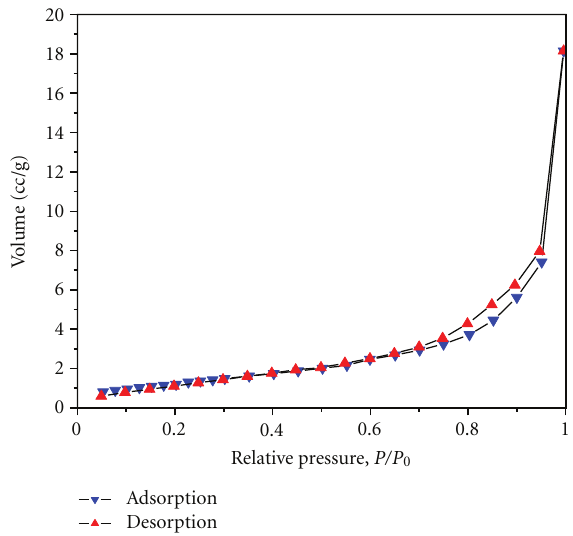
Figure 6: N 2 adsorption/desorption isotherm curve of the hierarchical CuO/ZnO nanomaterials.